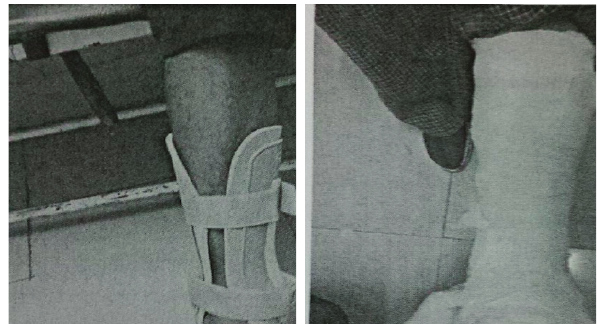
Figure 2: Below knee posterior slab splint Figure 3: Stirrup ankle brace The inclusion criteria were, first incidence of acute severe lateral ankle sprain following inversion injury of ankle (moderate and severe); presenting within 24h of injury; unable to bear weight on affected limb (Weight-bearing Table 1: The Karlsson scoring scale